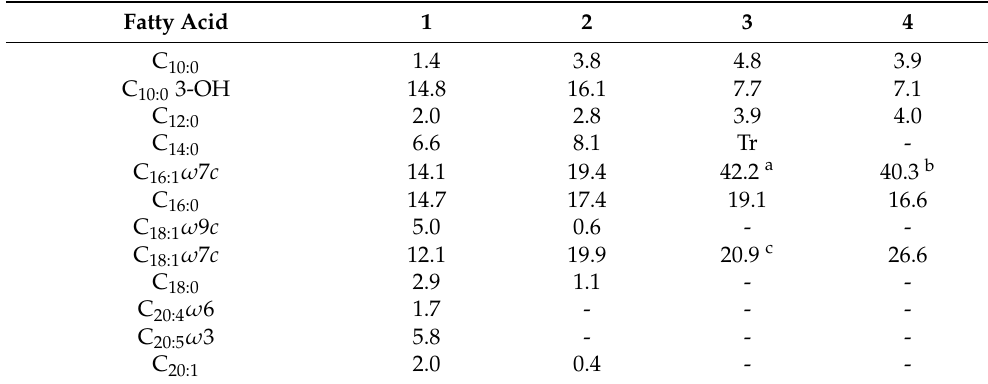
Table 2. Cellular fatty acid composition (%) of strain Marinobacterium sedimentorum sp. nov. KMM 9957 T and related type strains of the genus Marinobacterium .